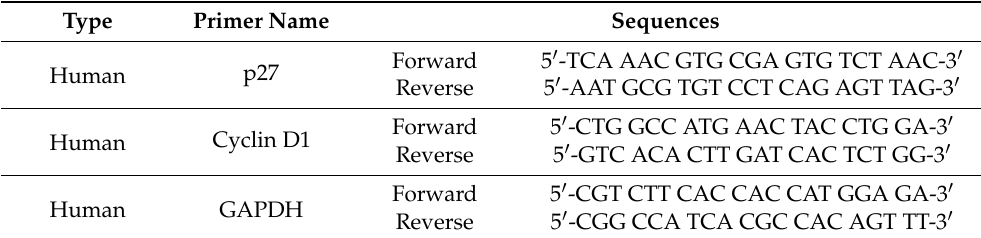
Table 1. Sequences of primers used for